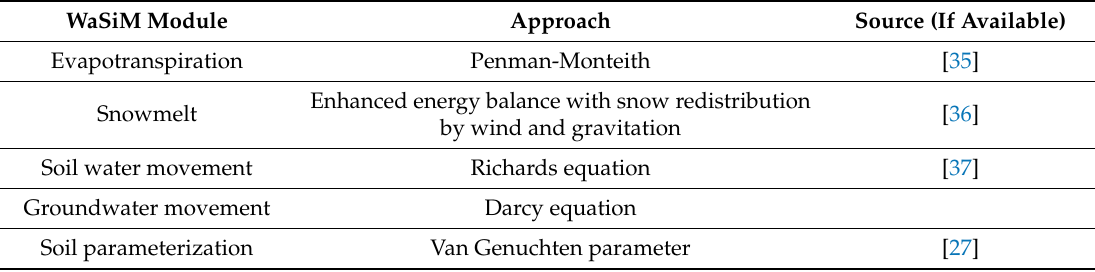
Table 2. Applied processes and their associated approaches within the WaSiM setup. WaSiM